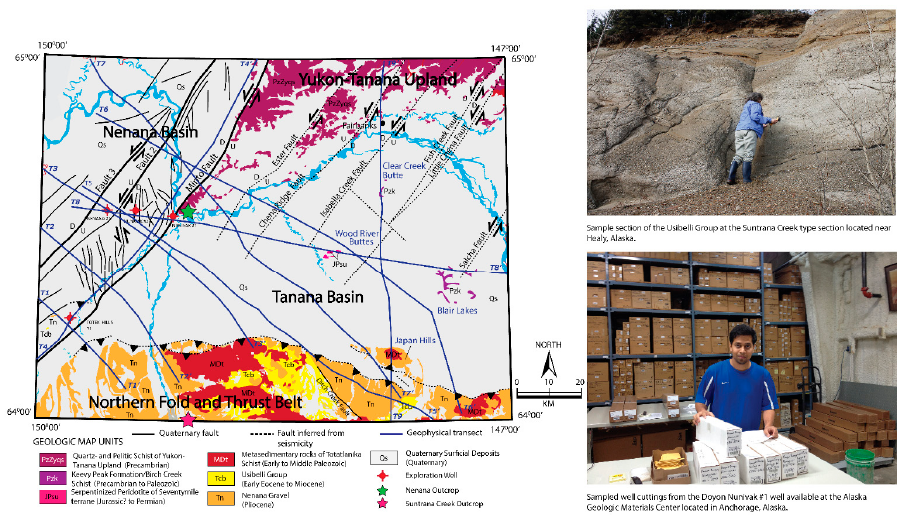
Figure 2. Geologic map of central Alaska, showing the Cenozoic-age Nenana and Tanana basins and exposed geology, including major lithologic units and regional fault systems. The present-day active faults are inferred from the available surface outcrops and active seismicity in the region [7–10]. Quaternary thrust faults (black solid line with thrust symbols) define the northern limit of the northern foothills in the fold-and-thrust belt of the Central Alaska Range [7]. Solid blue lines indicate the locations of profiles for the potential field models developed in this study. Geologic map modified from Wilson and all [28]. We collected 107 rock outcrop samples at the Suntrana Creek outcrop to measure the bulk densities and magnetic susceptibilities of rocks (inset on top-right). In addition to outcrop samples, we sampled 133 drill cuttings from the Nunivak-1 well at the Alaska Geological Materials Center (inset on bottom-right). Rock densities and susceptibilities are published by Dixit and Tomsich [29].